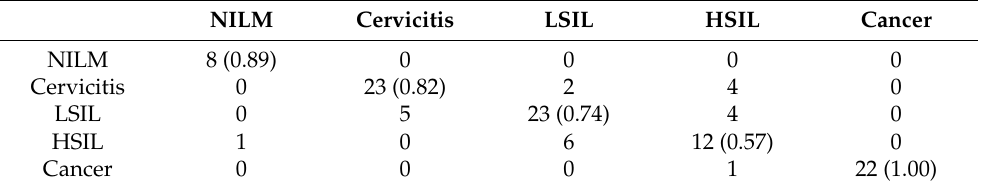
Table 3. Lipidome diagnostic contingency table for differential diagnosis of the severity of neoplastic lesions. Values in parentheses indicate the accuracy of each diagnosis.